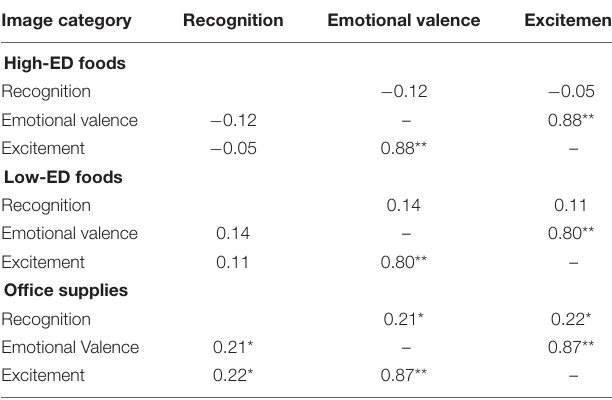
TABLE 5 | Pearson’s correlations between image ratings for recognition, emotional valence, and excitement.